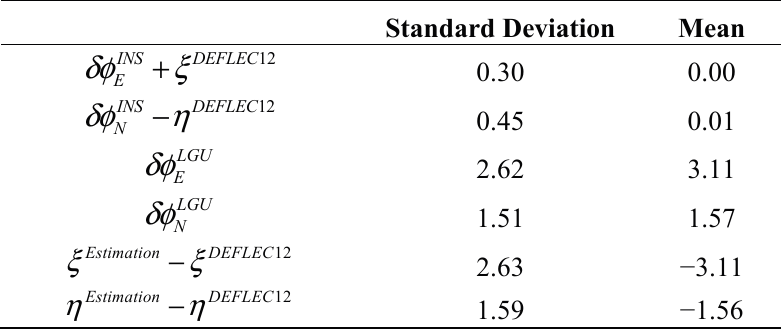
Table 2. Statistical analysis of the simulation result ( ″ ).